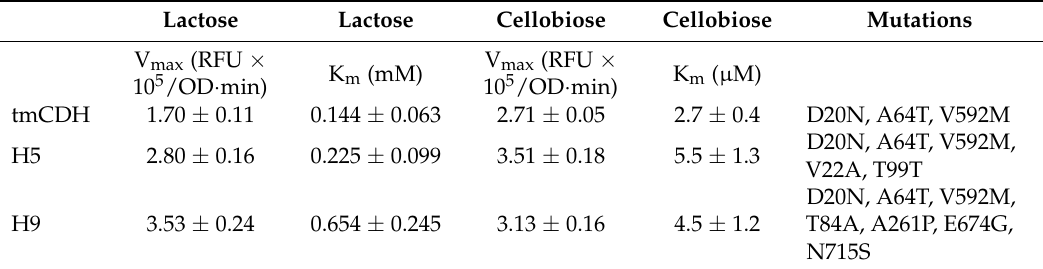
Table 1. Kinetics properties of CDH mutants. Enzymatic assay was done with resazurin (0.1 mM), lactose/cellobiose (different concentrations), sodium-phosphate buffer (0.1 M; pH 5.5), and fluorescence measured at ex/em 540/590 nm.